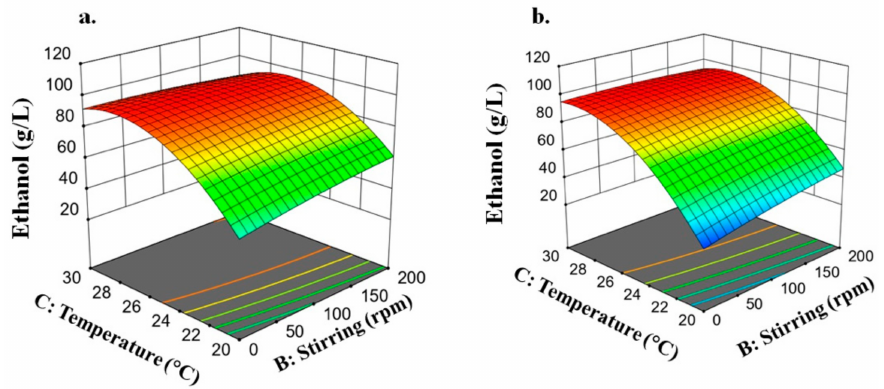
Figure 5. Effect of the temperature and stirring on the production of ethanol concentration during fermentation of hydrolysates obtained after pretreatment under ( a ) hydrothermal and ( b ) acid hydrolysis conditions. Fermentation pH = 5.50, fermentation time = 24